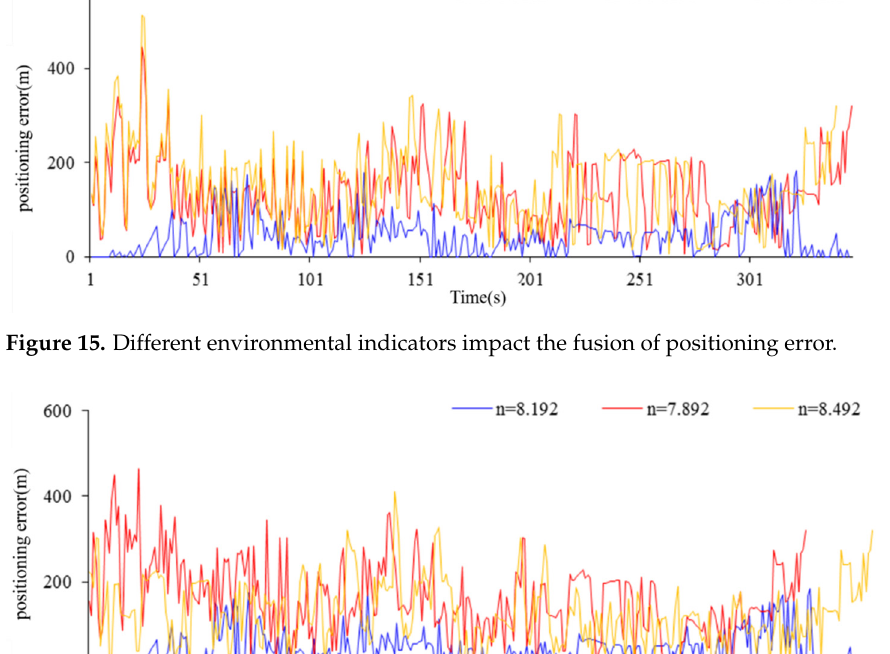
Figure 15. Different environmental indicators impact the fusion of positioning error.